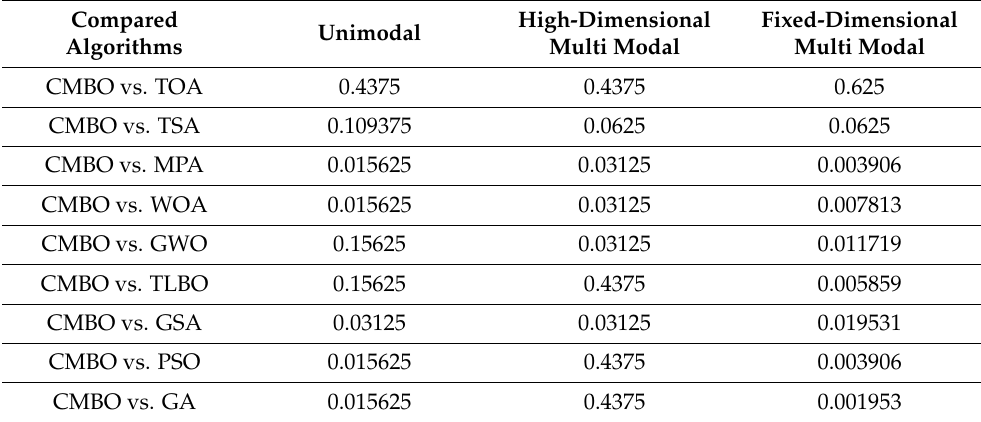
Table 7. Statistical analysis results from the Wilcoxon test ( p ≥